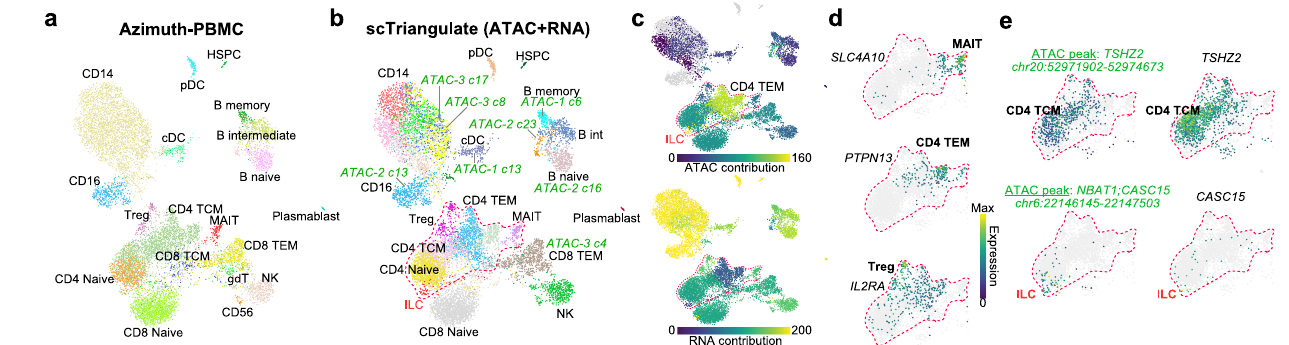
Fig. 4 | Multimodal integration identi fi es rare and unannotated cell states distinguished by DNA accessibility. a UMAP of multiome PBMC (RNA+ATAC) following Azimuth assignment of cell population identities. b scTriangulate fi nal clusters after integration of multiple RNA and ATAC clustering resolutions. c The selectivecontributionofeachindicatedmodalityisoverlaidontheUMAP,basedon